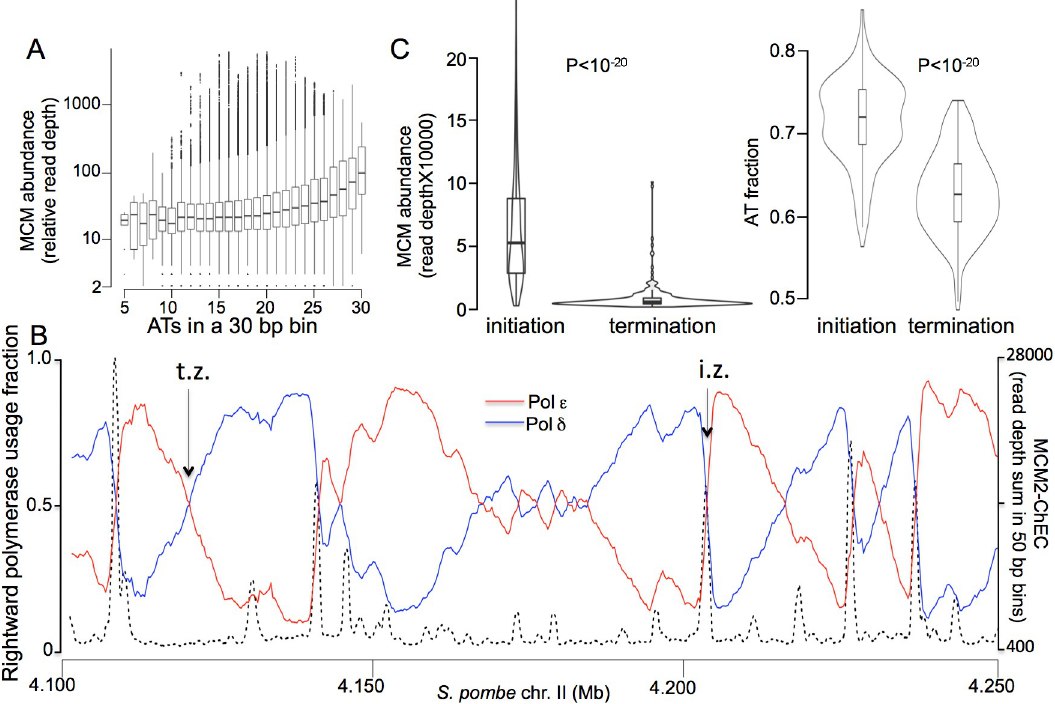
Fig 6. MCM binding preference in S. pombe with respect to AT content and replication initiation and termination zones. (A) MCM signal as a function of AT content was determined by dividing the genome into 30 base pair bins and measuring average MCM signal in all bins with 30/30 As and Ts, 29/30 As and Ts, etc. (B) Percentages of rightward moving polymerases (i.e. polymerases that are involved in creating the newly synthesized Watson strand) that are leading- (pol ε ) and lagging-strand (pol δ ) polymerases, as determined by Pu-seq [47], are shown in red and blue, respectively. MCM abundance, expressed as Mcm2-ChEC signal read depth sum of all fragment sizes in 50 bp bins on the left Y-axis, is indicated by dotted black lines. Zones at which leading- and lagging-strand polymerases diverge sharply indicate replication initiation zones; these appear as sharp downward movements of the blue trace with coincident sharp upwards movements of the red trace. Zones at which leading- and lagging-strand polymerases from adjacent replication initiation zones converge indicate replication termination zones; these appear as gradual downwards movements of the red trace with coincident gradual upwards movements of the blue trace. (C) Comparison of MCM levels at all initiation versus termination zones on chr. II. Initiation and termination zones were determined as described in Materials and Methods. Violin plot shows distribution of relative read depths. Box shows interquartile range; horizontal line shows median; horizontal line in box shows median; vertical lines extending above and below box show distance to point farthest from interquartile range that is still within 1.5 interquartile ranges from the edge of the box; any points outside of this range are shown as individual points. Mean value for initiations was 0.19 (relative per-base-pair read depth), with 95% confidence intervals extending from 0.17 to 0.21; for terminations, mean was 0.023, with 95% confidence intervals extending from 0.020 to 0.027, P < 10 − 20 . (D) Comparison of AT content at all initiation versus termination zones on chrII. Mean value for initiations was 0.715 with 95% confidence intervals extending from 0.709 to 0.721, and mean value for terminations was 0.629 with 95% confidence intervals extending from 0.622 to 0.635, P = 10 − 20